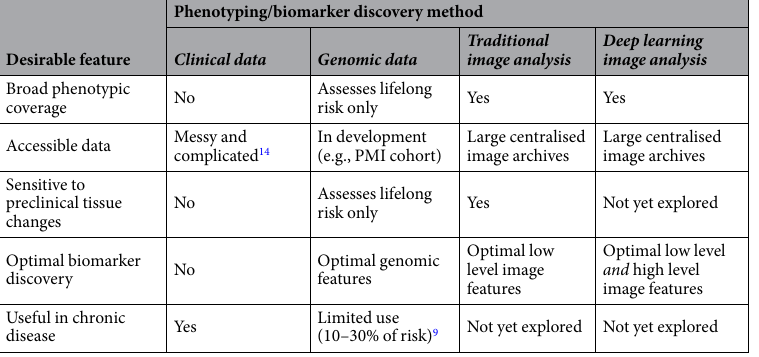
Table 1. Comparison of features of clinical data, genomic data, traditional feature engineering, and deep learning image analysis methods as potential phenotyping solutions for precision